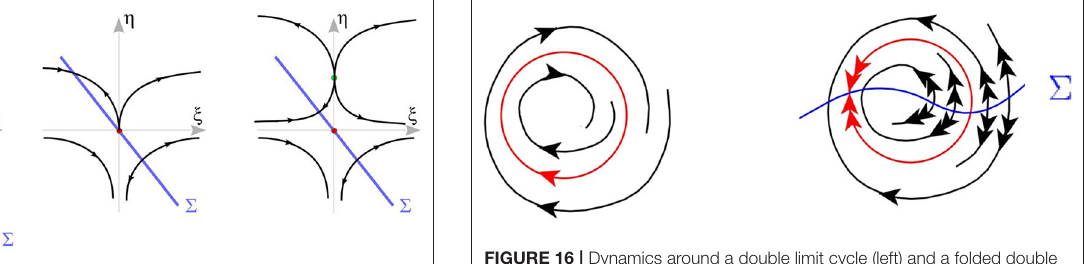
FIGURE 16 | Dynamics around a double limit cycle (left) and a folded double limit cycle (right) of Equation